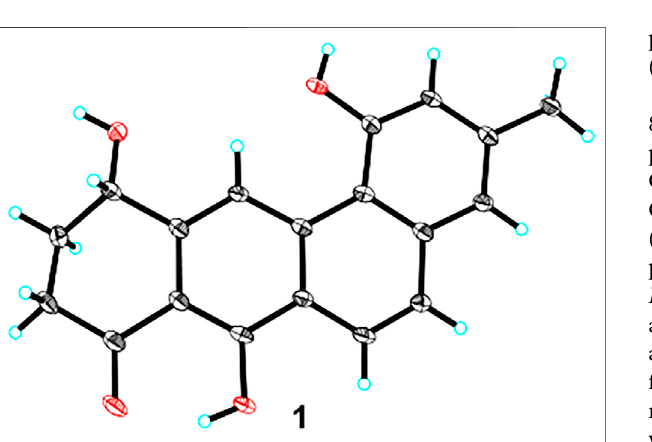
FIGURE 3 | X-ray crystal structure of